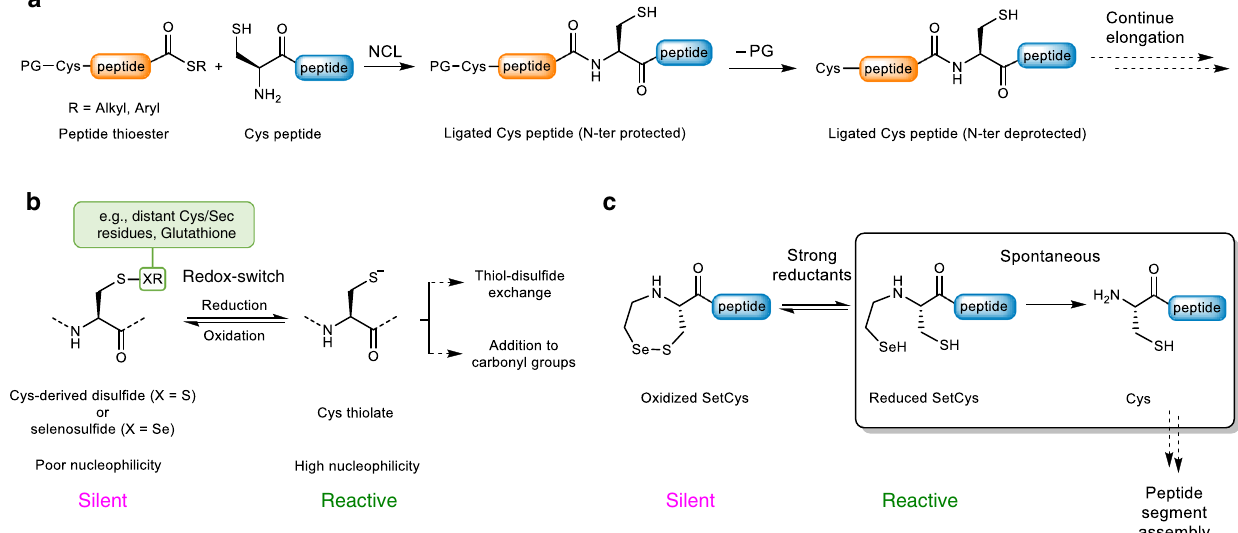
Fig. 1 The redox control of Cys reactivity can be a mild and powerful tool for the total chemical synthesis of proteins. a Principle of the native chemical ligation (NCL) between a C-terminal peptide thioester and a cysteinyl (Cys) peptide. The control of the site of ligation requires masking any other N- terminal Cys residue present in the mixture. b The reversible formation of disul fi de or selenosul fi de bonds is a hallmark of Cys thiol chemistry in proteins and is used by nature as a redox switch to control Cys thiol reactivity. c The N -(2-selenoethyl) group of SetCys shuts down the nucleophilic properties of Cys thiol by formation of a cyclic selenosul fi de bond. It is removed spontaneously in water at neutral pH under strong reductive